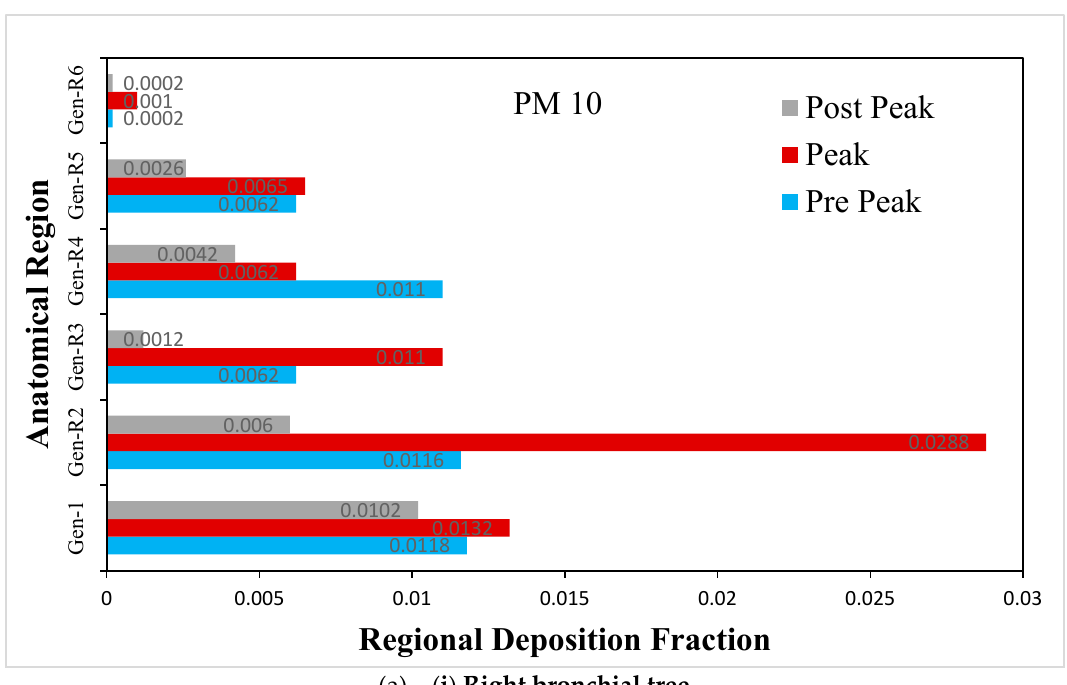
Figure 9. ( a ) Regional deposition fraction (RDF) of PM 2.5 during normal inspiration, ( b ) Regional deposition fraction (RDF) of PM 2.5 during moderate inspiration.